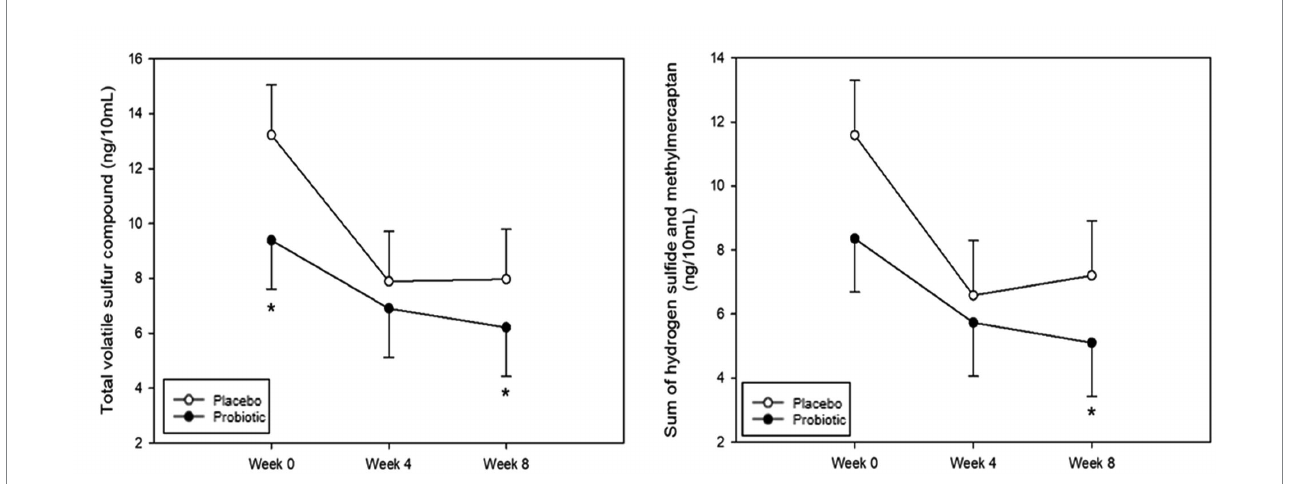
FIGURE 2 Analysis of volatile sulfur compounds. (A) Total volatile sulfur compound (VSC). Total VSC was significantly lower in the probiotics group than in the placebo group at baseline (week 0, p = 0.046) and at week 8 ( p = 0.017). (B) Sum of hydrogen sulfide (H 2 S) and methyl mercaptan (CH 3 SH). The sum of H 2 S and CH 3 SH levels was significantly lower in the probiotic group than in the placebo group at week 8 ( p = 0.012). Each line represents the least squares mean (LSmean) ± standard error (SE). *Value of p ≤ 0.05, Student’s t